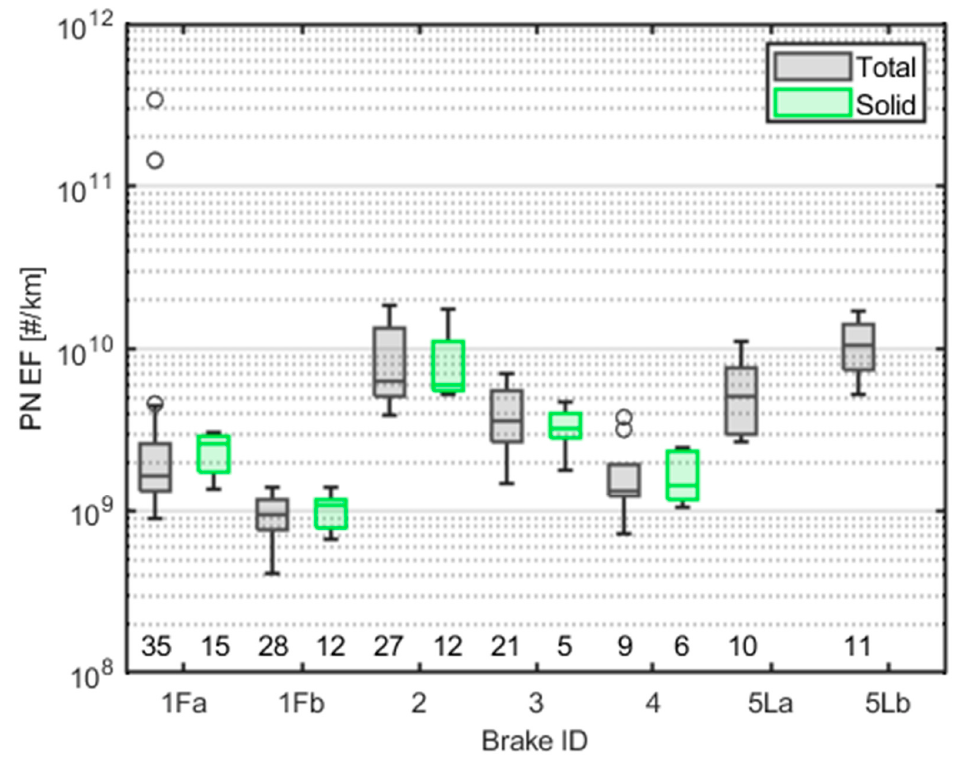
Figure 4. Overview of total and solid PN EF for different brake IDs from all labs (excluding Lab D, H, R, and Q). Boxplots indicate the median (lines in the box), upper and lower quartiles (box edges), and nonoutlier maximum/minimum. Note that the number of data points varies for each box and is underneath the corresponding boxplot for each brake.